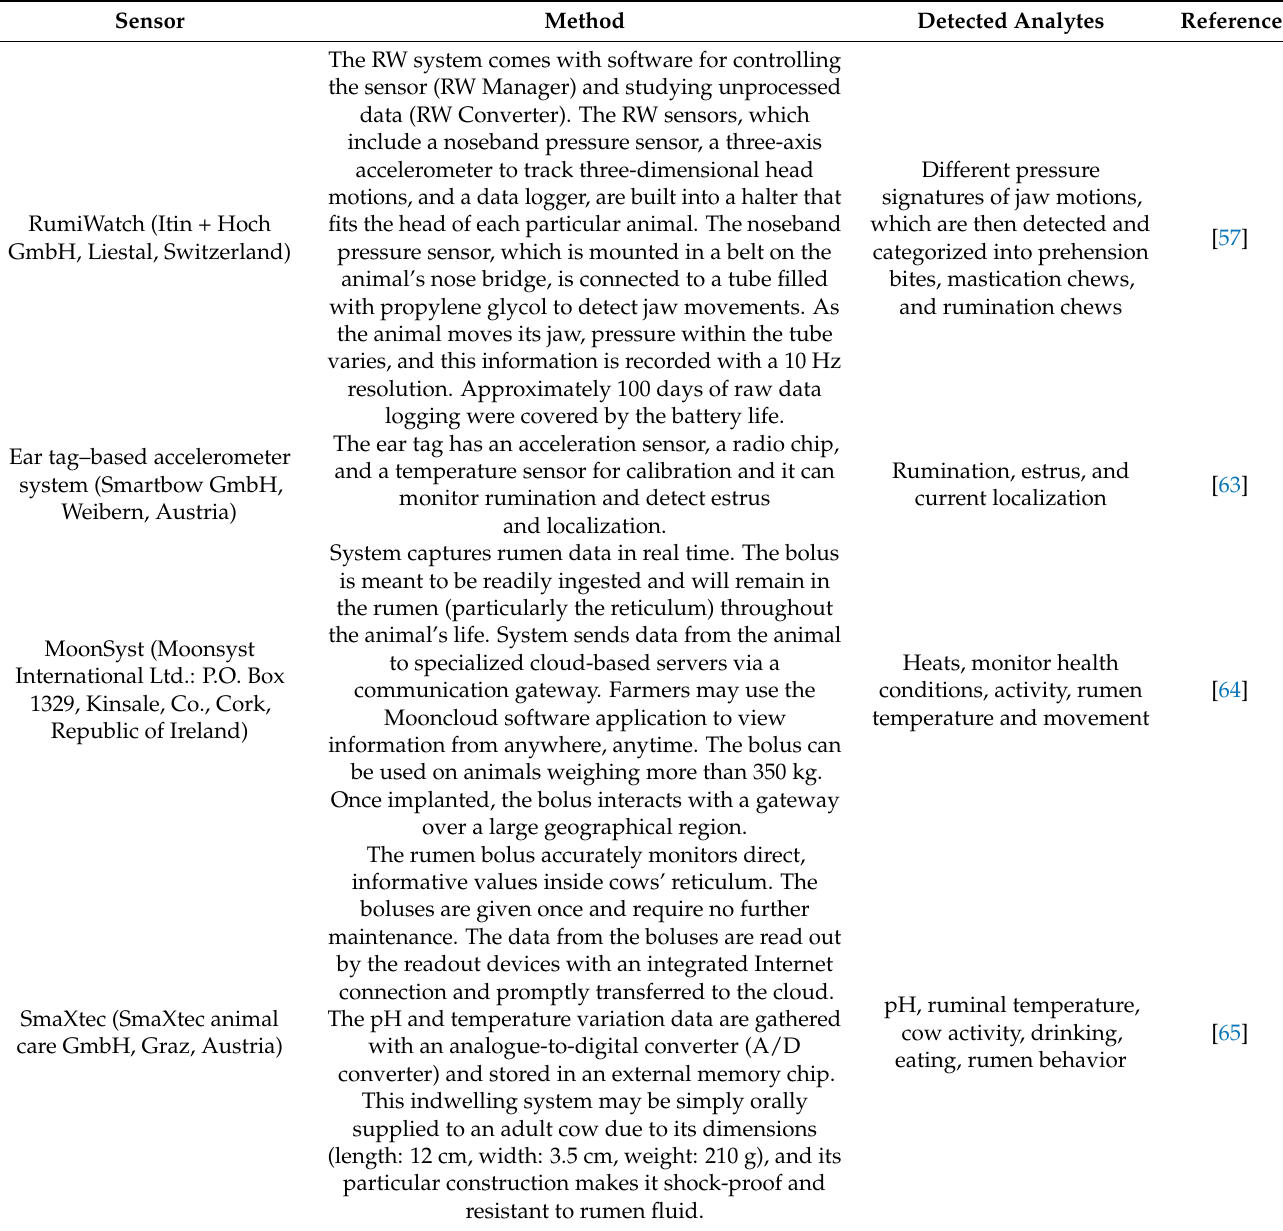
Table 2. Information about some of the commercial